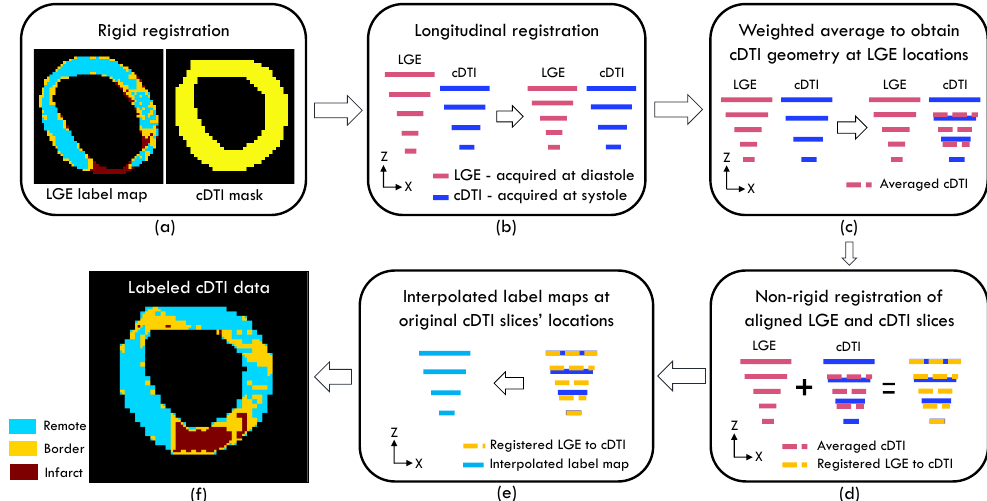
Figure 2. Diagram illustrating the registration process that was used to register LGE-based label maps to cDTI slices. ( a ) Quaternions were used to rigidly register LGE-based label maps to cDTI binary masks to ensure that both LGE and cDTI were in the same image space. ( b ) Since LGE was acquired during diastole and cDTI was acquired during systole, the longitudinal spacing between the LGE slices was reduced to reflect the contracted LV state during systole. This shortening was achieved by matching the basal and apical LGE and cDTI slices. ( c ) Although the basal and apical LGE and cDTI slices were aligned, the rest of the slices were not aligned. Hence, the cDTI slice masks at the z -axis location of the LGE slices were obtained via weighted average. ( d ) To obtain label maps at the cDTI location, aligned LGE-based label maps and weighted averaged cDTI slices were non-rigidly registered. ( e ) The cDTI label maps obtained in step ( d ) were at the z -axis location of the LGE slices. Hence, 3D interpolation was carried out to obtain label map values at the z -axis location of the original cDTI slices. ( f ) Based on the 3D interpolation, label maps for the remote (blue), border (yellow), and infarct (red) regions were obtained at the original cDTI slices’ locations. To reflect the left ventricle (LV) longitudinal shortening during systole, spacing along the z -axis between LGE-based label map slices was reduced uniformly on a subject-specific basis. This was accomplished by matching the z coordinates of the most basal and apical LGE slices with the corresponding most basal and apical cDTI slices (Figure